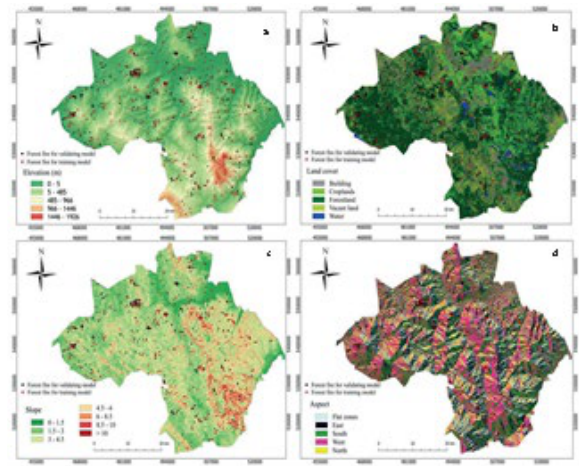
Figure 2. Fire conditioning factors (a. Elevation; b. Land Cover; c. Slope; d. Aspect).